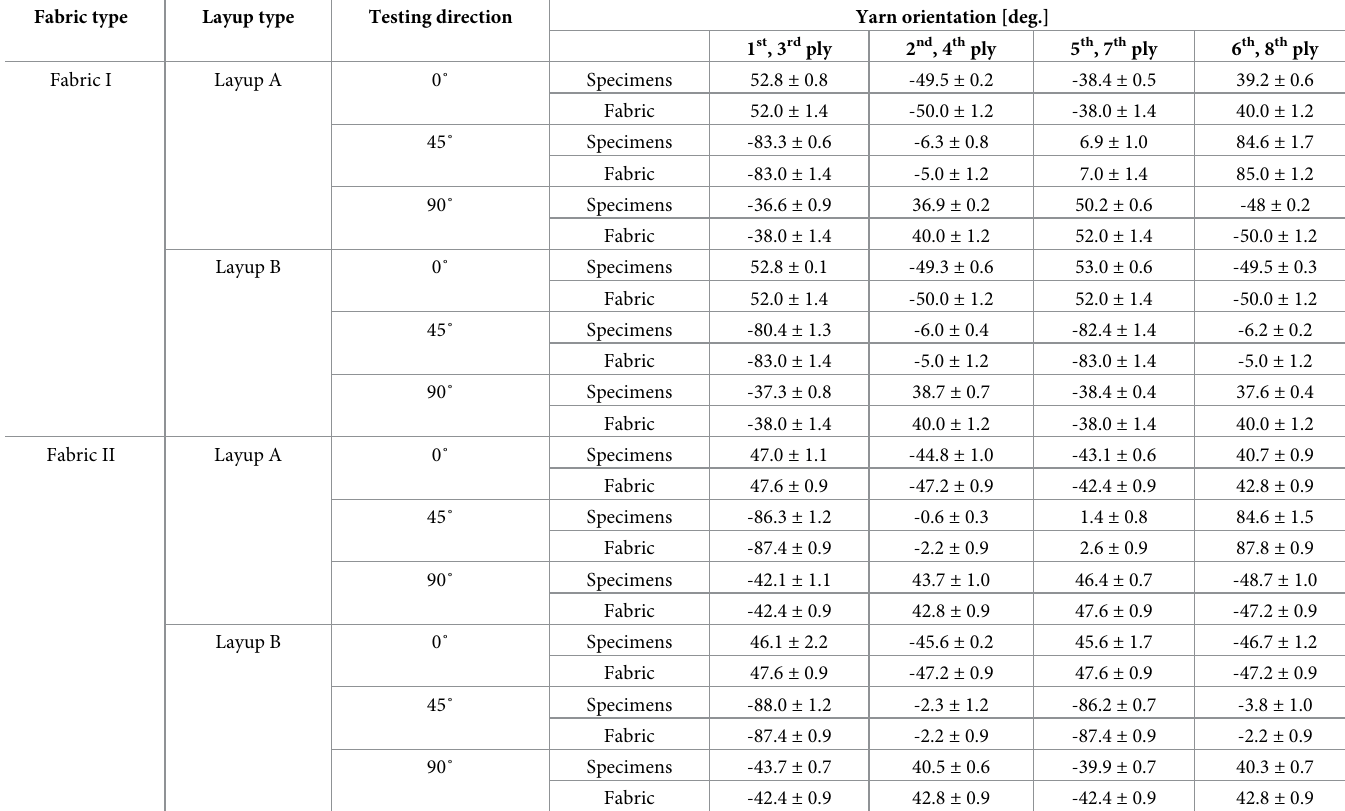
Table 3. Measured yarn orientation in tensile specimens of the multiaxial composite laminates with fabric I and II. The testing direction of the specimens is used as the reference direction for the measured yarn angles (see Fig 4). Presented is also fabric based yarn orientation in the specimens calculated from the measured yarn orienta- tion in the